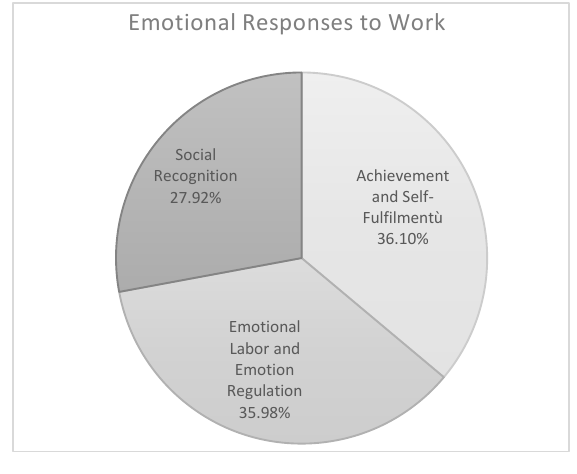
Figure 6. Theme n. 3.